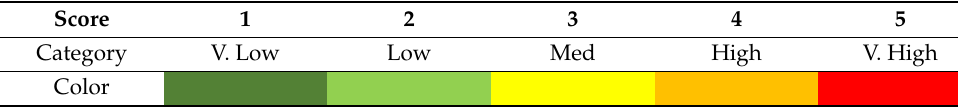
Table 6. Vulnerability maps color